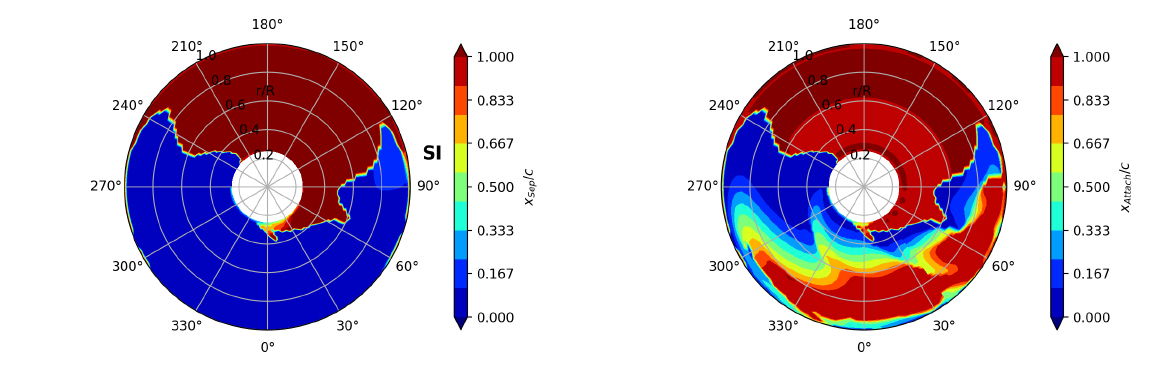
Figure 14. Rotor map of chord-wise separation x Sep / c and attachment x Attach / c locations. The direction of the free stream is from Ψ = 180 ◦ to Ψ = 0 ◦ , and the rotating direction is counterclockwise.